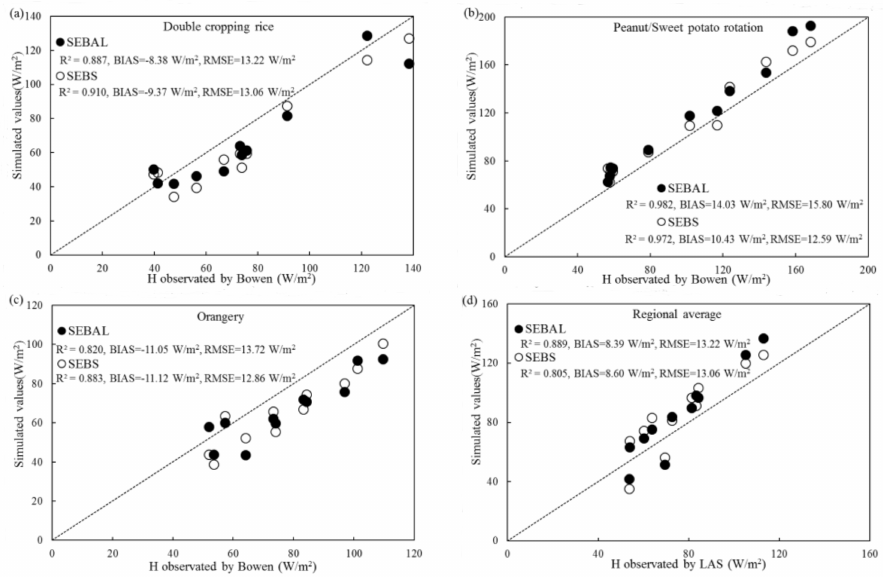
Figure 5. ( a – c ) Comparison of simulated sensible heat flux with the observed values by Bowen at a single point: ( a ) double cropping rice; ( b ) peanut/sweet potato rotation; ( c ) orangery; ( d ) Comparison of the simulated sensible heat flux with the observed values from LAS at the ecosystem